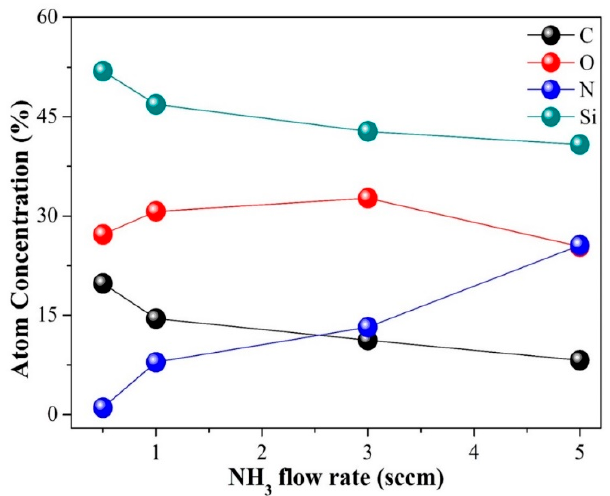
Figure 5. The atom concentration of Si, C, O, and N of the SiCO:N films against the NH 3 flow rates.